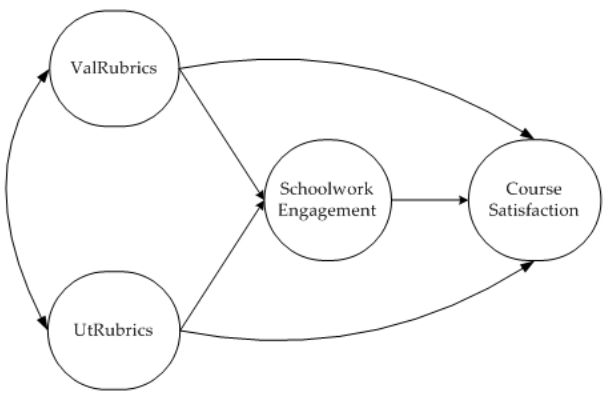
Figure 1. Hypothesized structural model. ValRubrics: rubrics’ validity; UtRubrics: rubrics’ useful- ness.